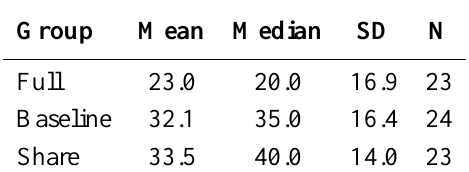
Table 4. Level of co-insurance (%) selected in period